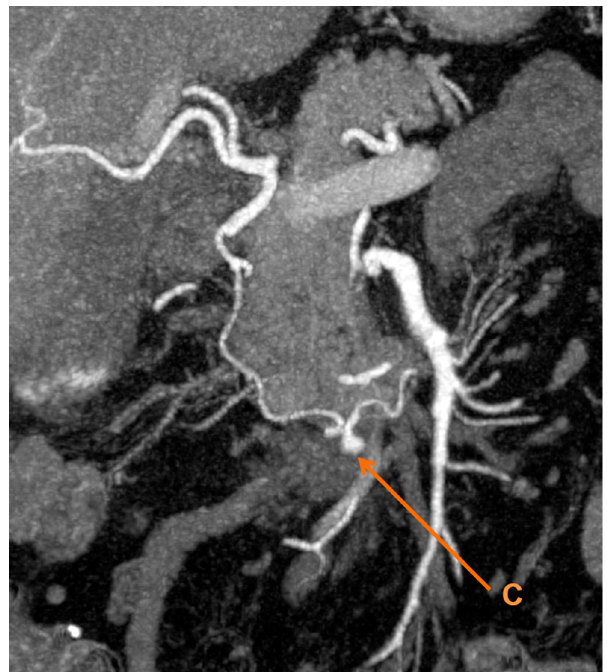
Figure 2. 3D maximum intensity projection reconstruction of the computed tomography showing ( C ) a pseudoaneurysm of the inferior pancreaticoduodenal